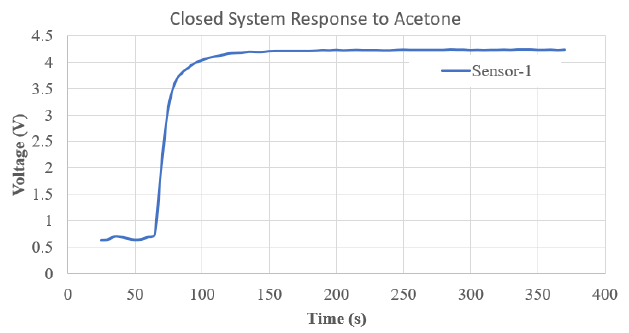
Figure 1. Response of Sensor-1 to acetone over time in an air-tight chamber.